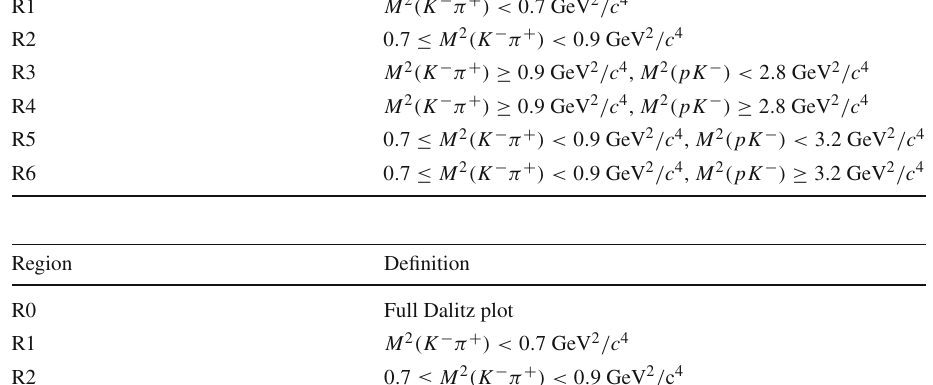
Region Definition